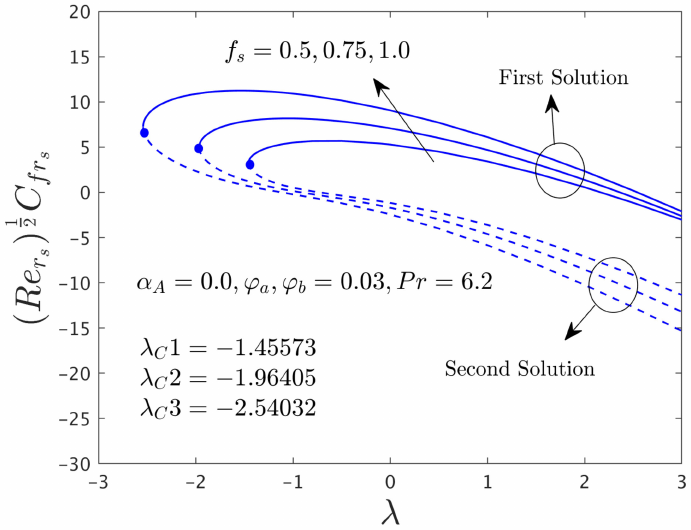
C fr against λ for numerous choices of f s . s s